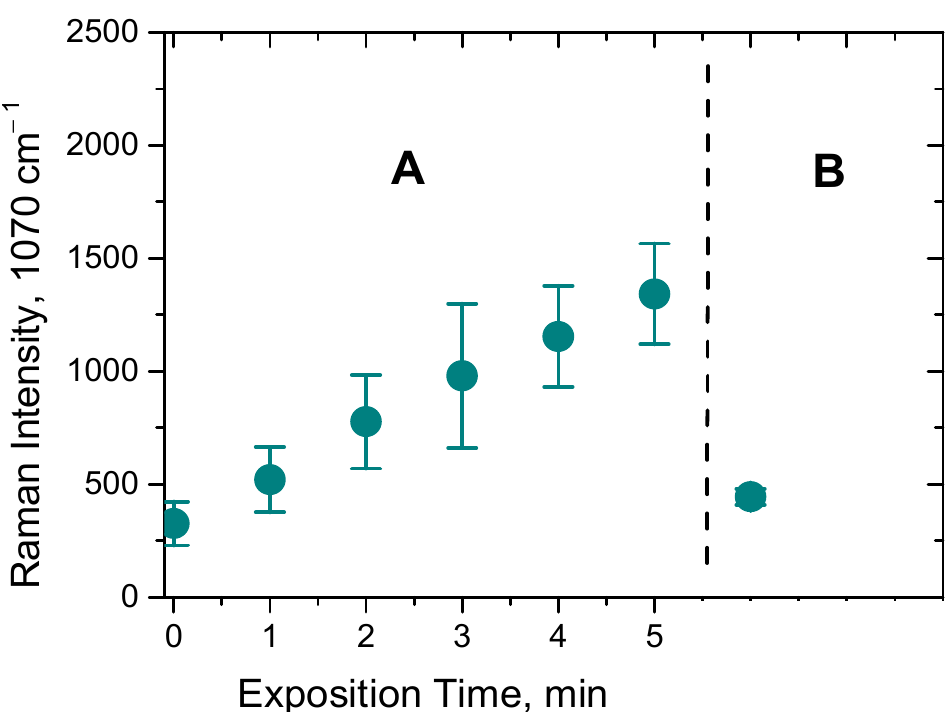
Figure 5. ( A ) The intensity increase in the 4-MPBA characteristic peak at 1070 cm − 1 upon 5 cycles of a local laser exposure of a drop of the AgNPs/PB- b -PDMAEMA hybrid labeled with 4-MPBA; ( B ) The intensity of the 4-MPBA characteristic peak at 1070 cm − 1 upon mixing a drop of the sample of the AgNPs/PB- b -PDMAEMA hybrid labeled with 4-MPBA. The data are presented as the mean ± SD for three independent experiments.